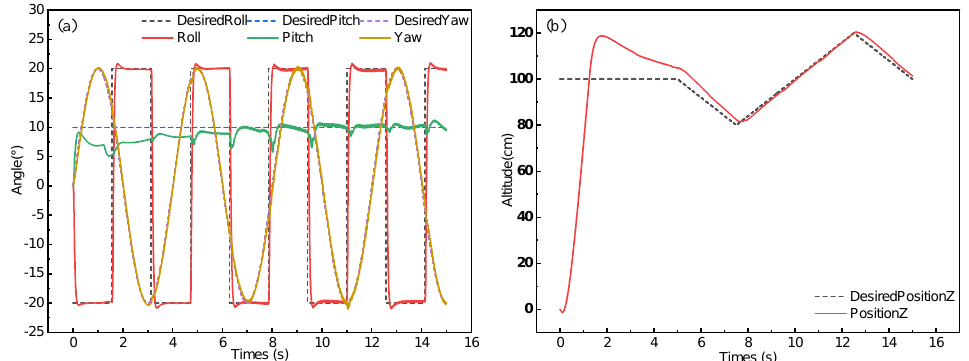
Figure 7. Simulation results of the attitude and altitude controlled by the PID controller. ( a ) Simulation results of attitude control. ( b ) Simulation results of altitude